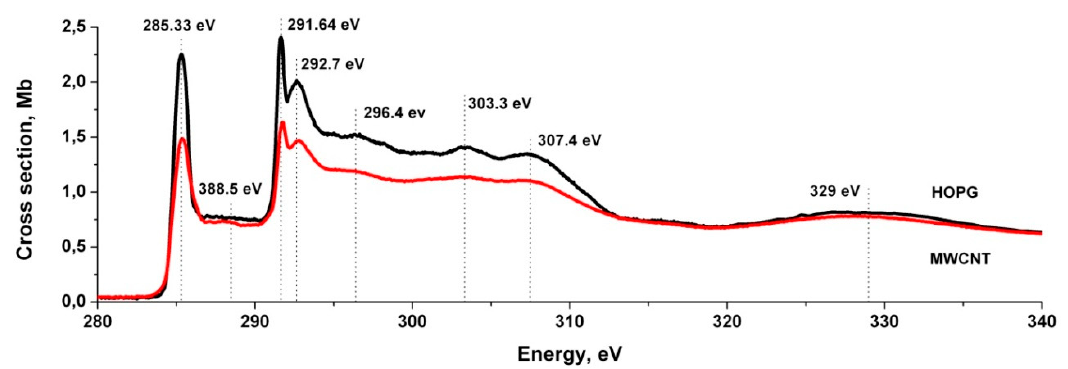
Figure 3. Absorption cross section spectral dependences in the region -edge X-ray absorption fine structure (NEXAFS) C1s edge of MWCNTs (red) and HOPG for an angle of 40° on the normal to the sample surface (black).